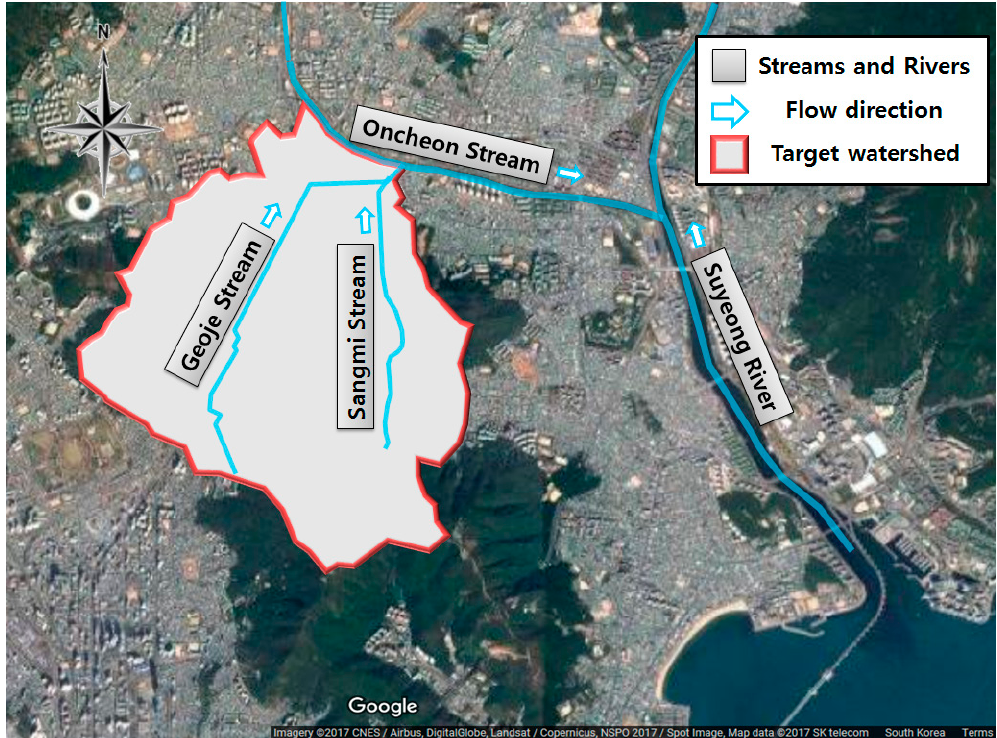
Figure 4. Geographical information of the target area (Imagery © 2017 Centre National d’Etudes Spatiales/Airbus, DigitalGlobe, Landsat/Copernicus, NSPO 2017/Spot Image, Map data © SK telecom). Geoje and Sangmi Streams were located in the target watershed. The lengths of Geoje and Sangmi Streams are 4.26 and 2.87 km, respectively. The area of the target watershed is 9.65 km 2 . The Storm Water Management Model (SWMM) 5.0 was selected for the rainfall runoff simulations and applied to the target watershed [21]. Information on the drainage network in the target watershed is based on the geographic information system (GIS) data for Busan provided by the Busan Metropolitan